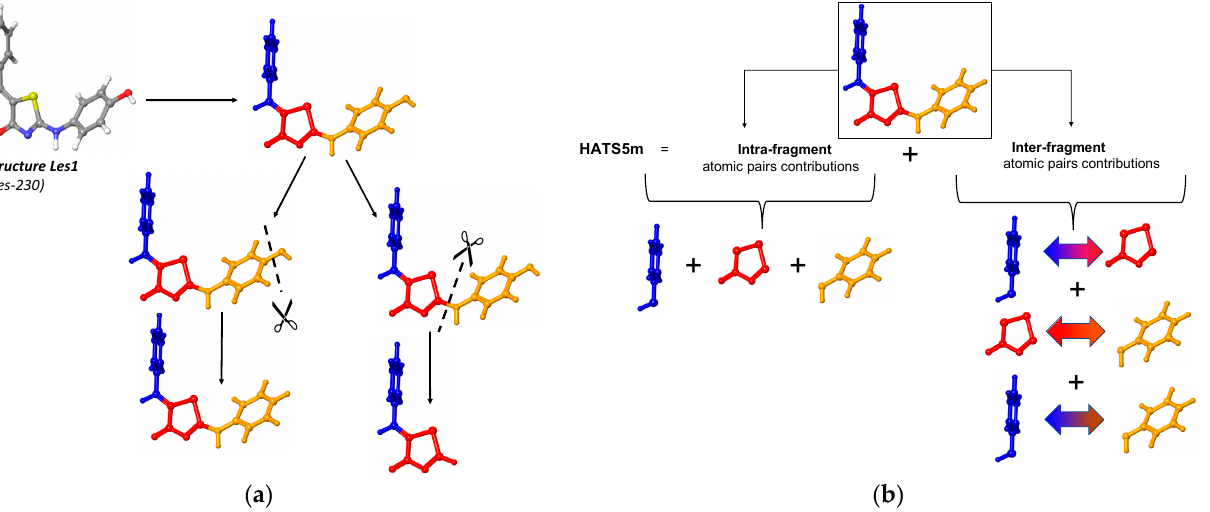
Figure 4. Visual explanation of the substructure ‐ based approach: ( a ), HATS5m as the sum of the individual fragment’s contributions: intra ‐ and inter ‐ fragment effects ( b ).